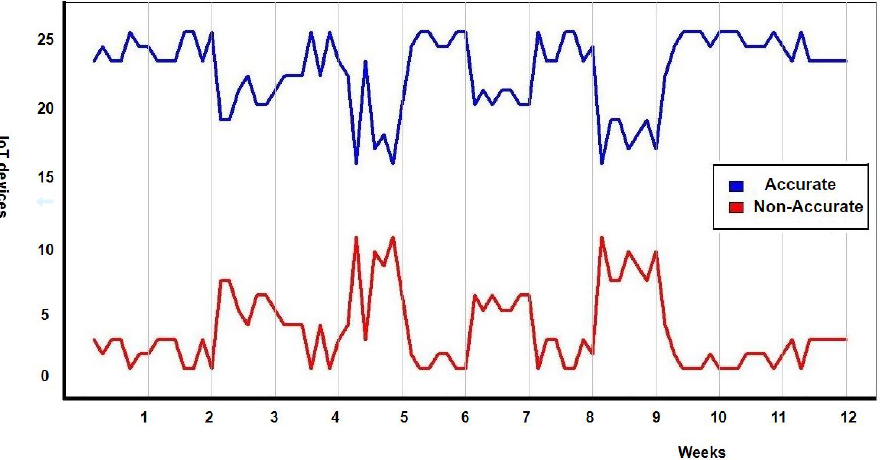
Figure 5. Number of accurate and inaccurate sensors during the 12 weeks of the case